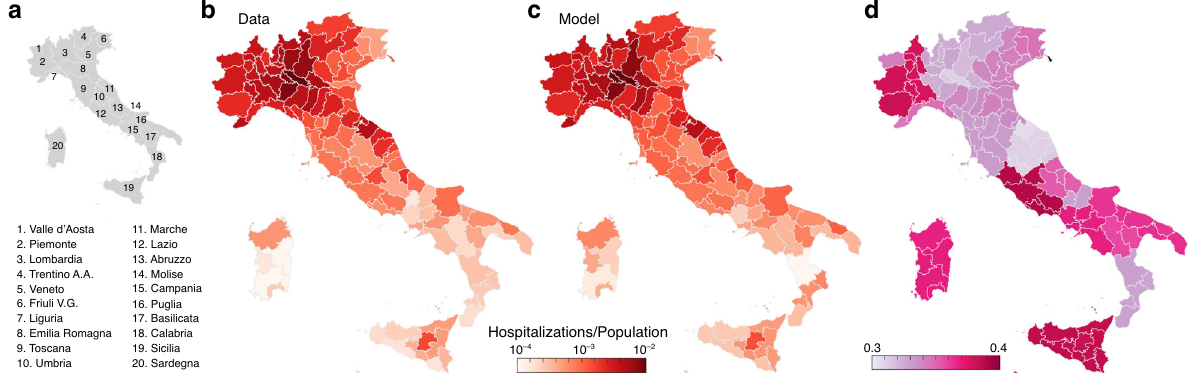
Fig. 1 Geography of COVID-19 spread in Italy. The comparative analysis of data and model results for hospitalizations in 107 Italian provinces as of May 1, 2020 is supported by: a a sketch of the Italian regions; b , c the prevalence of cumulative hospitalizations in each Italian province up to May 1, reconstructed data ( b ) and model simulations ( c ); d ratio between the estimated transmission rate on May 1, and the one estimated at the beginning of the outbreak (February 24).